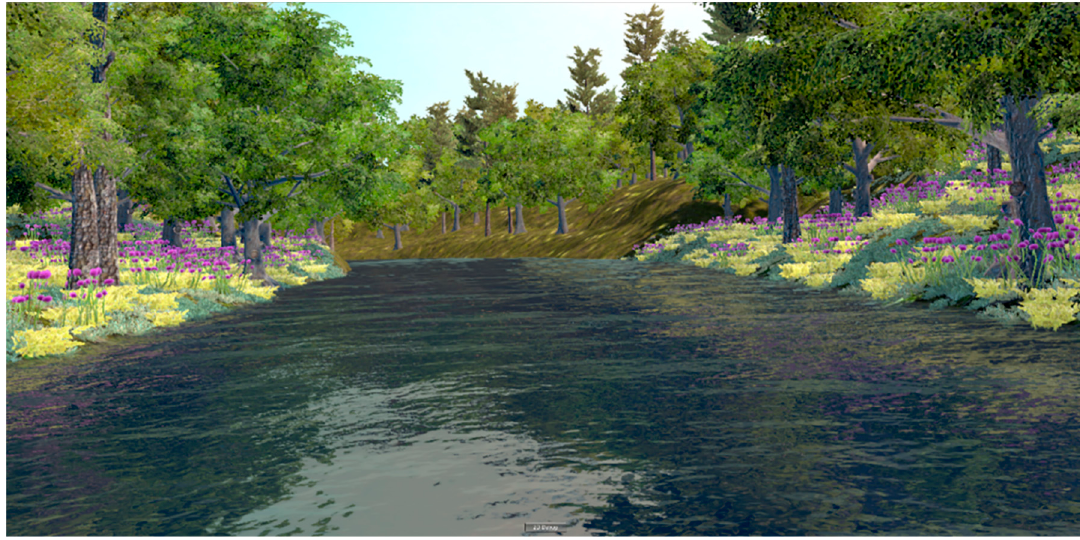
Figure 2. 3D virtual reality (VR) scene of a fluvial reach.